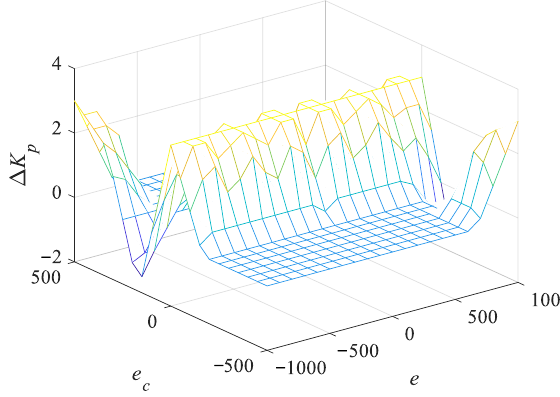
Figure 4. Fuzzy control surface of ∆ K p